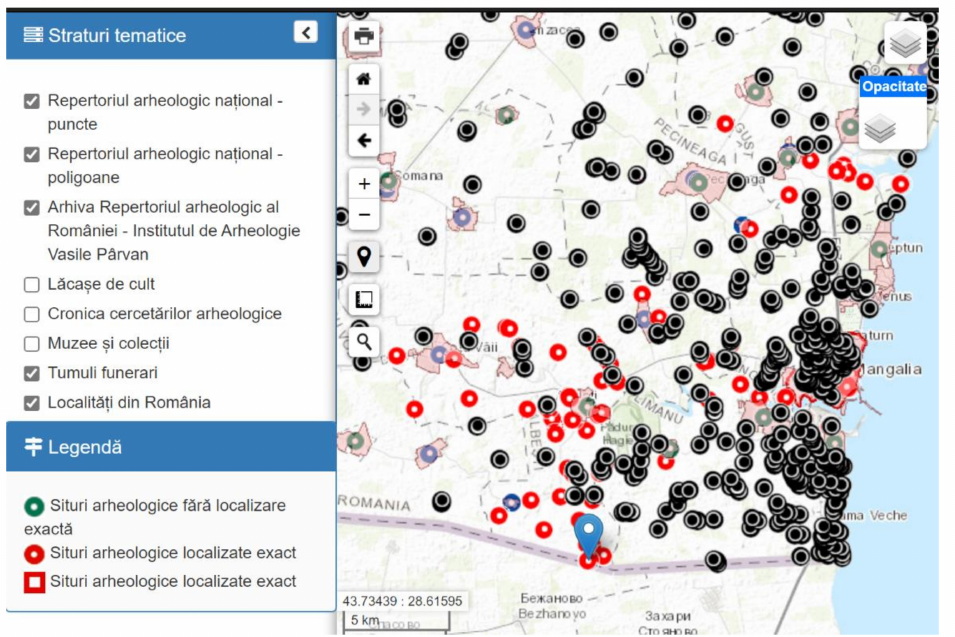
Figure 6. Romania, the R.A.N. website: screenshot with archaeological sites represented (“burial tumulus” type).